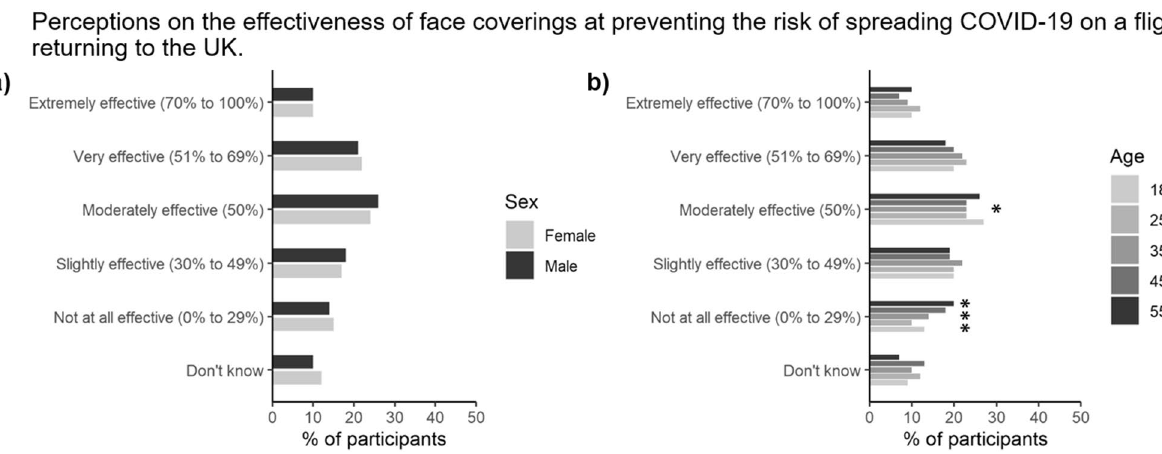
Figure 8. Proportion of participants stratified by either ( a ) gender, or ( b ) age ( n = 2103). *, **, and *** represent significant differences between the gender or age categories for a particular symptom at the P < 0.05, P < 0.01 or P < 0.001 level,